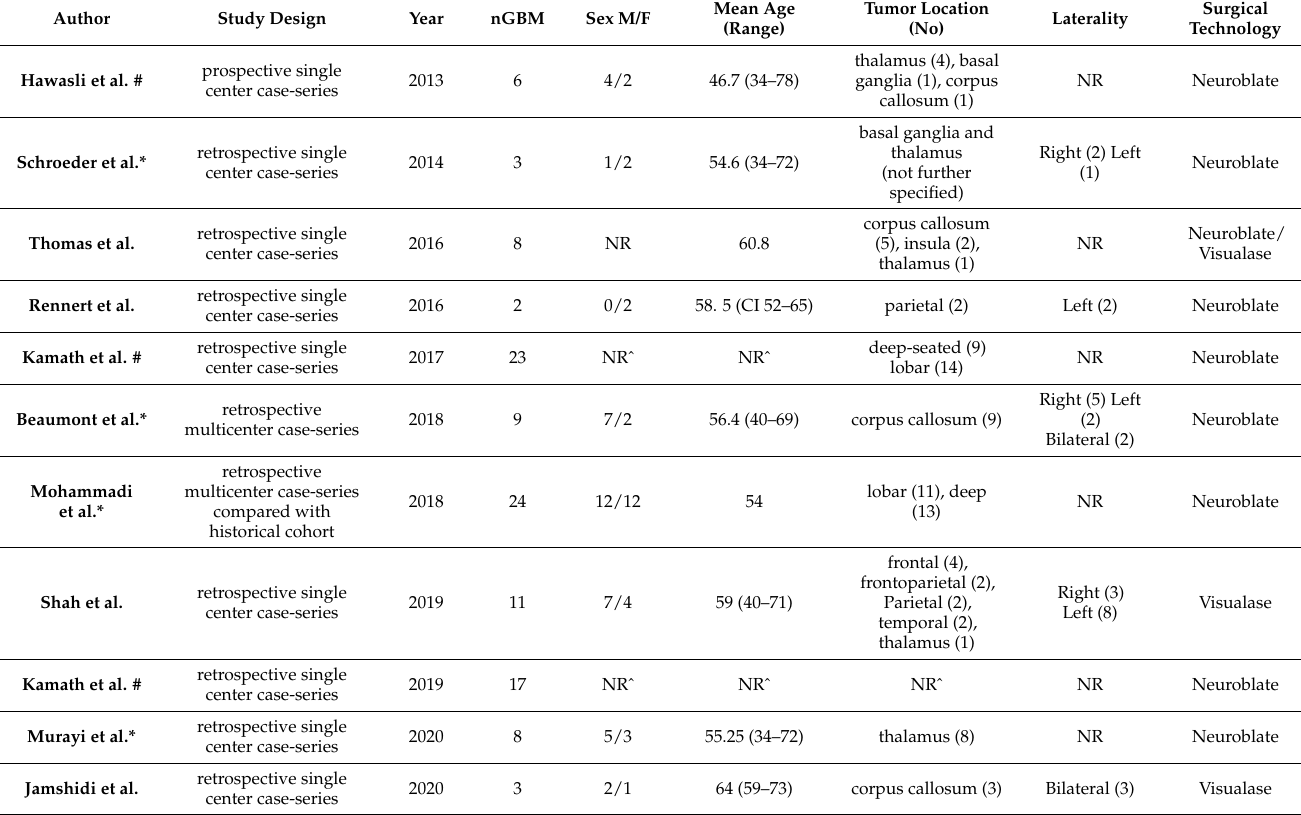
Table 3. Study characteristics and patients’ baseline. First author, study design, year of publication are reported; number of cases of nGBM, sex, mean age with range or CI, tumor location and technology used are